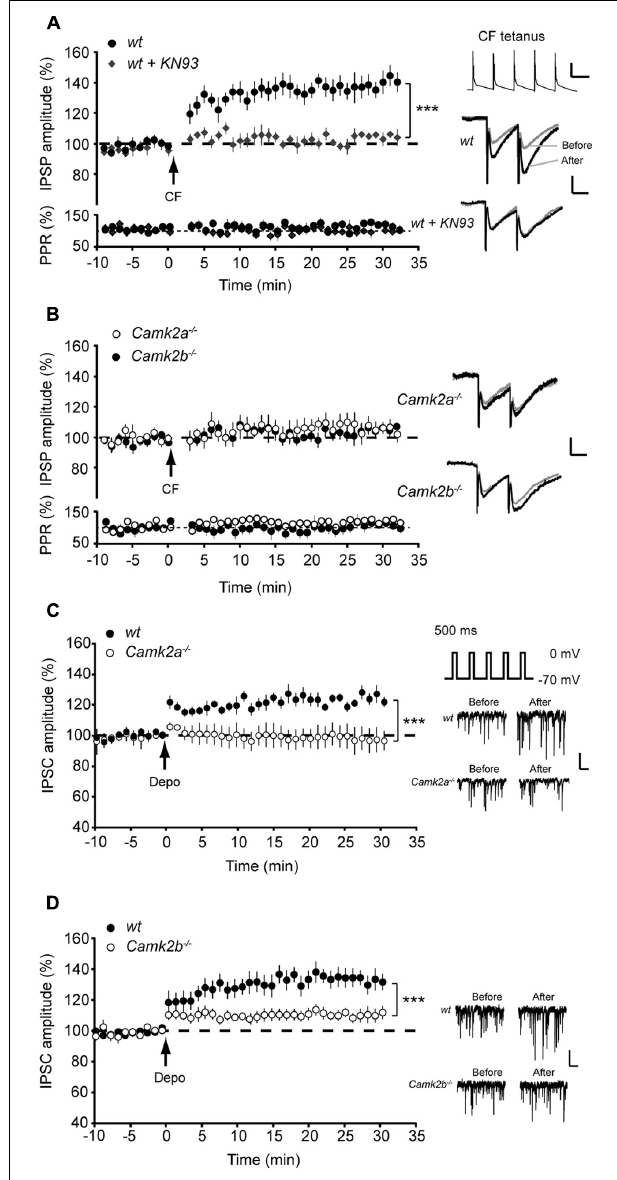
FIGURE 1 |Aberrant iLTP at MLI-Purkinje cell synapses in α and β CaMKII knockout mice. ( A ;Top) Five pulses, 10 Hz climbing fiber (CF) stimulation repeated every 2 s for 3 min yields iLTP in wildtype (wt, n = 10) Purkinje cells but not in wt Purkinje cells in the presence of KN-93 (wt + KN93, n = 6). (Bottom) Accompanying paired pulse ratio of IPSPs. Inset: representative traces of CF stimulation, scale bars 20 mV/100 ms and representative traces of IPSP before and after the CF stimulation, scale bars 1 mV/25 ms. (B) CF stimulation did not induce iLTP in Camk2a − / − ( n = 9) and Camk2b − / − Purkinje cells ( n = 8). (C) Inset shows schematic drawing of rebound potentiation experiment and representative traces of sIPSC, scale bars 50 pA/200 ms. Rebound potentiation in Purkinje cells was induced by five 500 ms depolarization pulses to 0 mV at 0.5 Hz; IPSC amplitudes were compared before and after tetanus. Impaired rebound potentiation in Camk2a − / − mice (wt, n = 7; Camk2a − / − , n = 6). (D) Impaired rebound potentiation in Camk2b − / − mice (wt, n = 8; Camk2b − / − , n = 9). Error bars represent SEM. Asterisks with brackets indicate statistical significance between wt and knockout mice (Student’s t -test of averages over last 5 min). *** p <